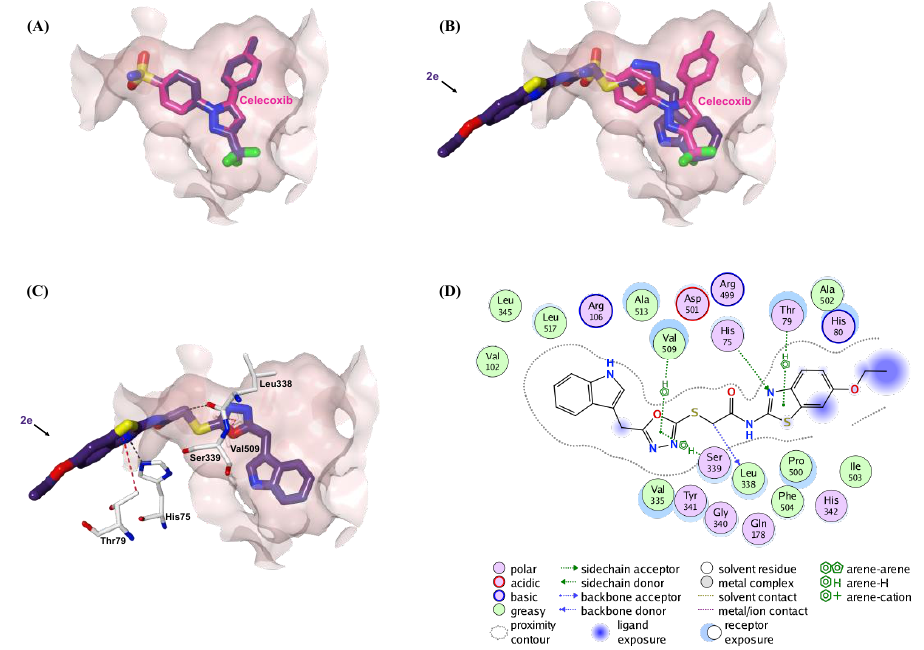
Figure 4. The top-scoring docked pose of compound 2e bound to the active site of COX-1 (PDB code 3KK6). The active site is displayed in surface view (light grey). ( A ) Comparison of modeled binding mode of the co-crystallized ligand celecoxib (magenta sticks) and its superimposed docking conformation (cyan sticks). ( B ) Comparison of modeled binding mode of compound 2e (cyan sticks) and celecoxib (magenta sticks). ( C ) Detailed binding mode of compound 2e (cyan sticks) displaying hydrogen bonds (black dashed line) and CH –π interaction (red dashed line) with the critical amino acid residues (white sticks). ( D ) Two-dimensional depiction of compound 2e binding interactions with the essential amino acid residues.